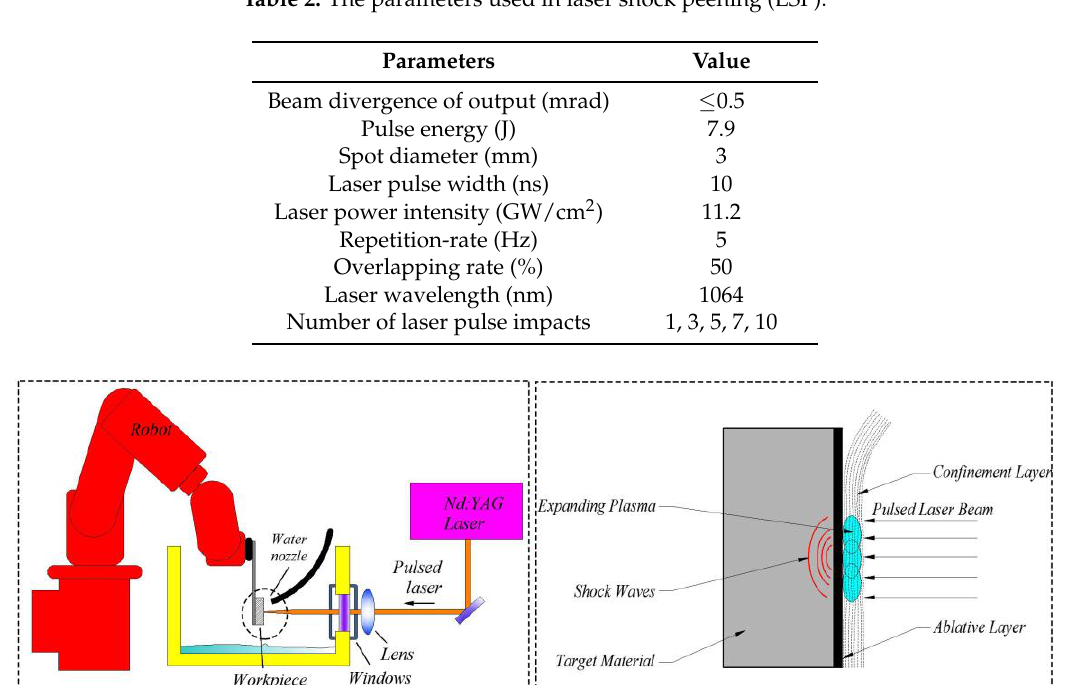
Table 2. The parameters used in laser shock peening (LSP).